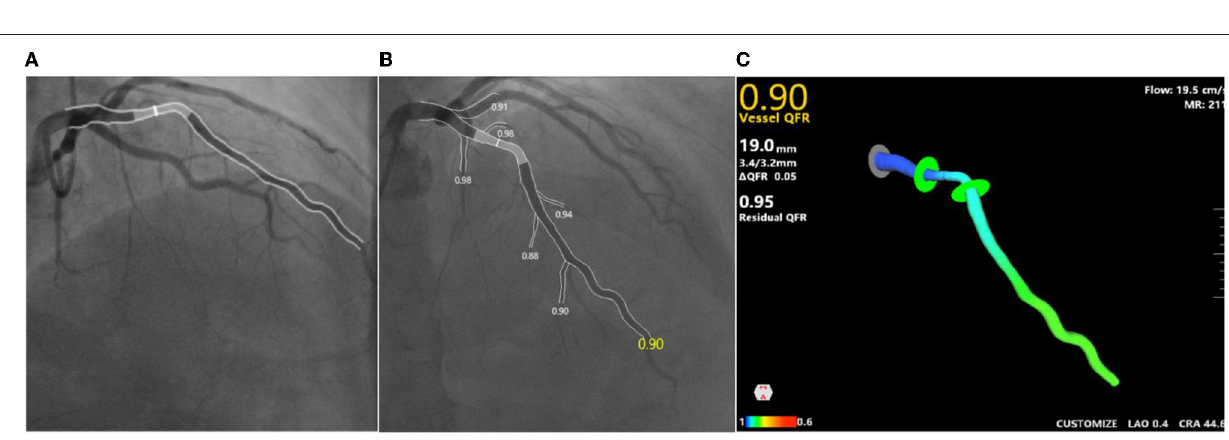
FIGURE 3 | An example of QFR and MR analysis. (A,B) Angiographs of two angles of one same culprit lesion; (C) cQFR is 0.9, MR is 211mm Hg*s/m, flow speed is 19.5cm/s. cQFR, contrast-flow quantitative flow ratio; MR, microcirculatory